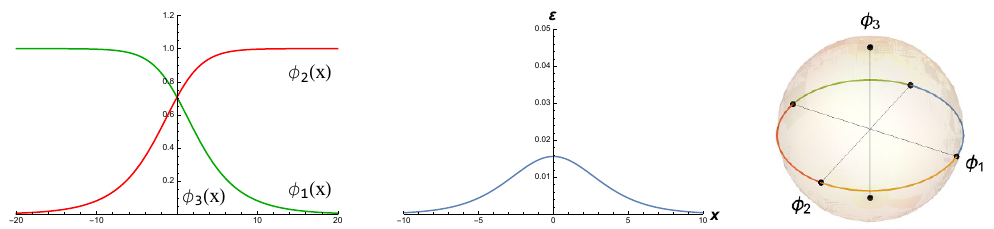
Figure 1 . Pro(cid:12)le of the Cartesian (cid:12)eld components (left), wall tension density (middle) and orbits for the K ( q;a;b ) ( x ) domain walls 1